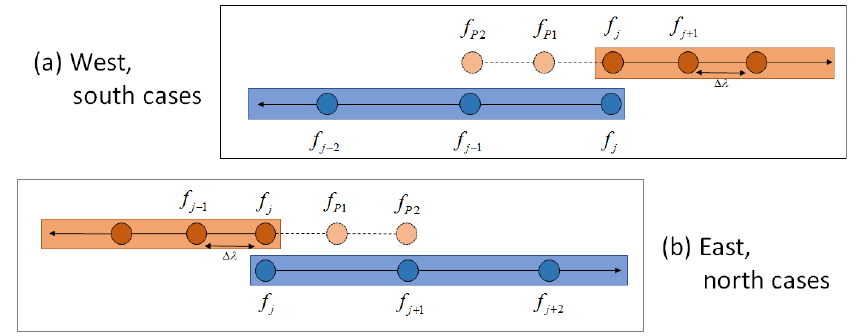
Figure 6. Halo interpolation stencil for the four edges: (a) west, south and (b) east, north.